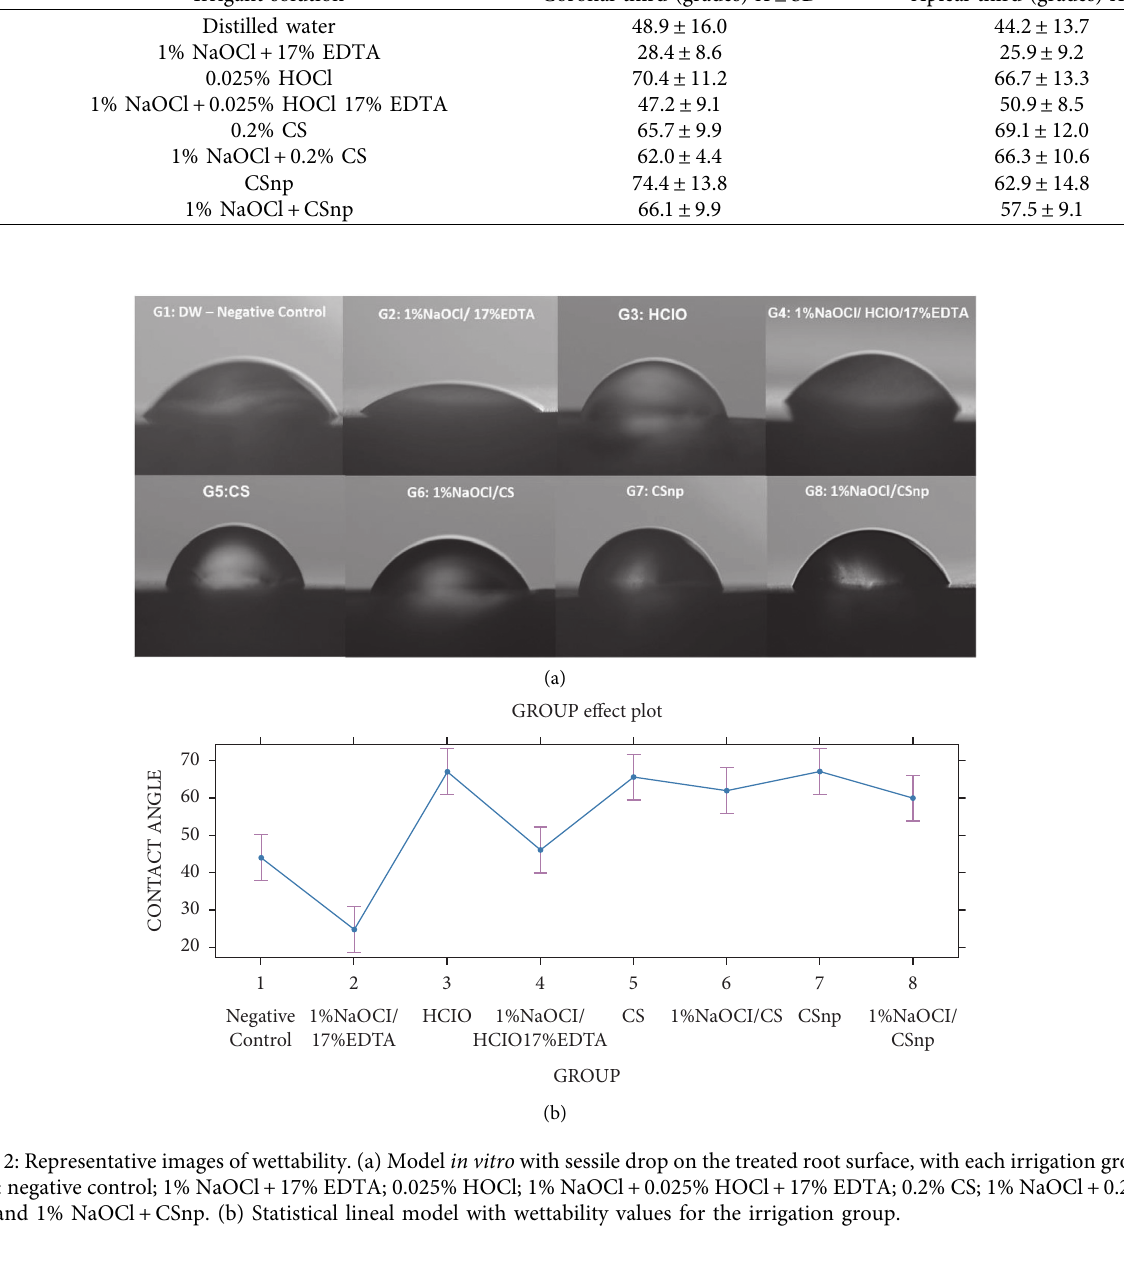
Figure 1: (a) Experimental scheme for the measurement of the contact angle ( θ ).1- Micropipette, 2- sessile drop (SE), 3- irrigation protocol, 4- camera, and 5- computer. (b) Diagram of the surface tensions: c LG, liquid-gas; c SL, surface-liquid; and c SG, surface-gas. Table 1: Mean ( x ̄ ) and standard deviation (SD) values for the contact angle ( θ ). Group